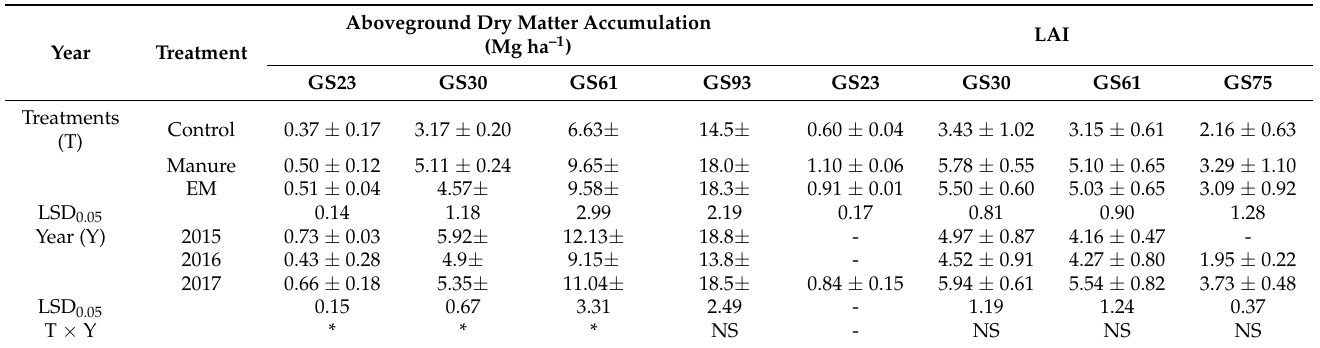
Table 4. The dynamics of aboveground dry matter accumulation and leaf area index (LAI) for three treatments over 3-year study period.